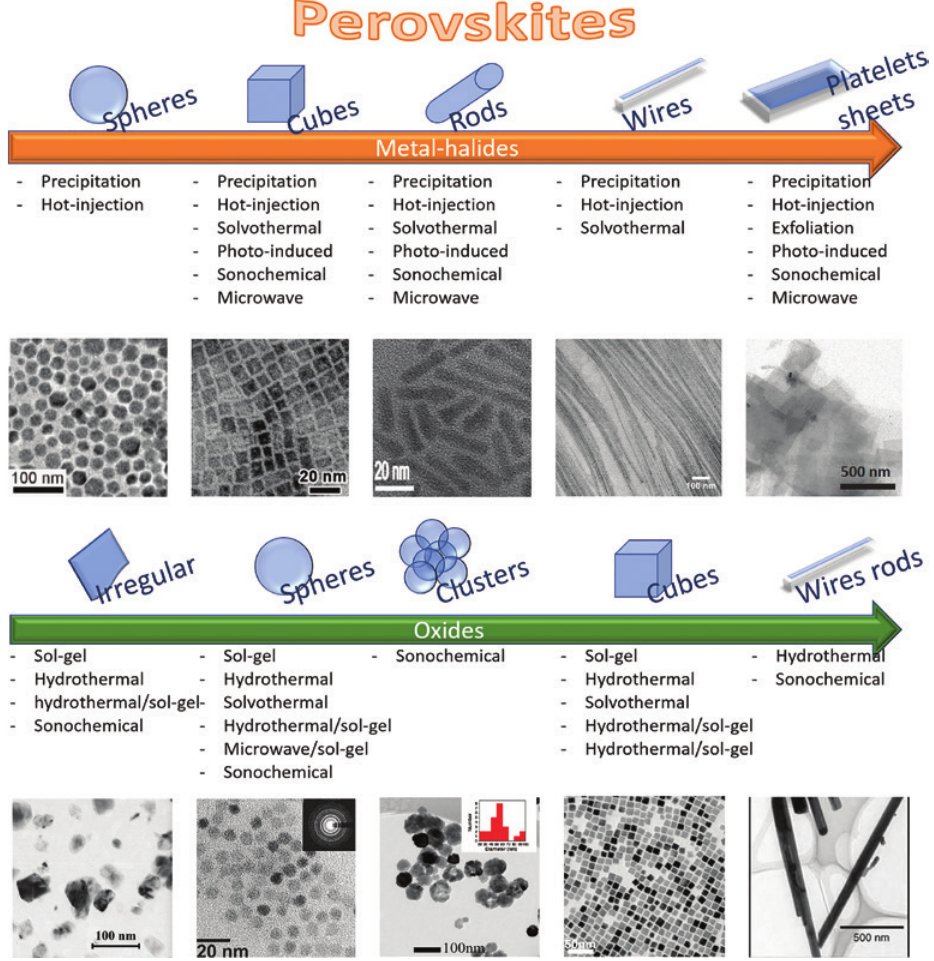
Figure 2: Summary of the solution-processed synthesis procedures of various perovskite nanocrystal